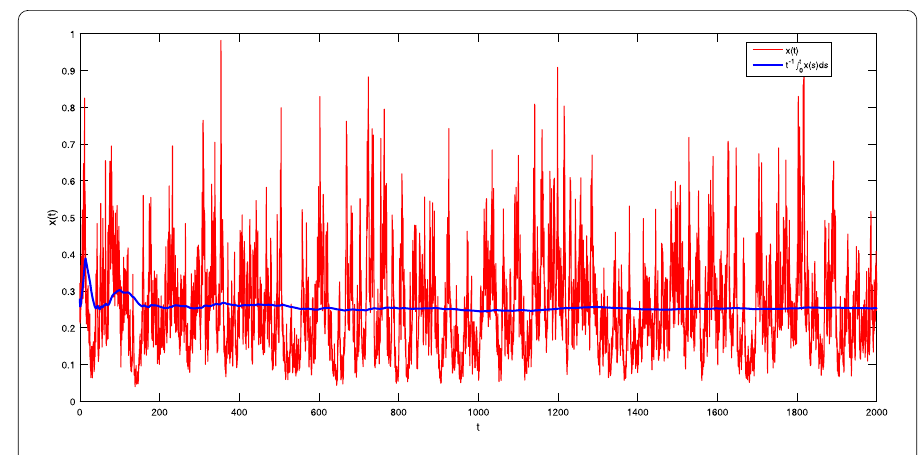
Figure 5 Solution of system (2) with σ 1 = 0.3, σ 2 = 0.2, σ 3 = 0, σ 4 = 0, σ 5 = 0.4, u = 0.3, γ =